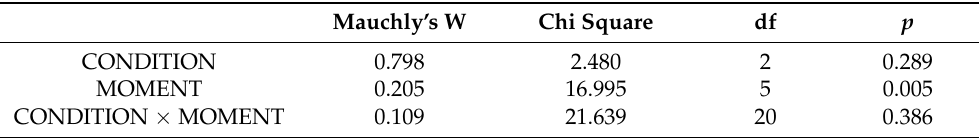
Table 12. Mauchly’s Test of Sphericity for the two factors and their interaction. Mauchly’s W CONDITION CONDITION × MOMENT Design: Intersection. Intra-subjects design: CONDITION + MOMENT + CONDITION × MOMENT. Table 13. Pairwise comparisons for the MOMENT factor. Measurement: pulse rate. MOMENT (I) MOMENT (J) Mean Difference Std. Error